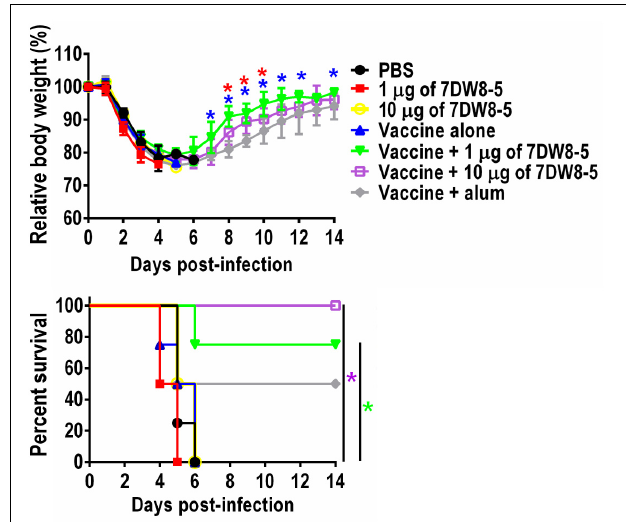
FIGURE 2 | Protective efficacy of 7DW8-5 plus vaccine against lethal challenge. Six-week-old BALB/c mice ( n = 4) were mock-immunized with PBS or 7DW8-5 alone, immunized with HA vaccine alone or 7DW8-5-adjuvanted HA vaccine twice with a 2-week interval between vaccinations. Mice were intranasally challenged with 10 MLD 50 of MA-CA04 virus 3 weeks after the second immunization. Body weight and survival were monitored daily for 14 days. The body weight data shown are means ± standard deviation (SD). Green asterisks indicate a significant difference between the vaccine alone group and the vaccine plus 1 µ g of 7DW8-5 group; purple asterisks indicate a significant difference between the vaccine alone group and the vaccine plus 10 µ g of 7DW8-5 group; blue asterisks indicate a significant difference between the vaccine plus 1 µ g of 7DW8-5 group and the vaccine plus alum group; red asterisks indicate a significant difference between the vaccine plus 10 µ g of 7DW8-5 group and the vaccine plus alum group. ∗ P < 0.05.